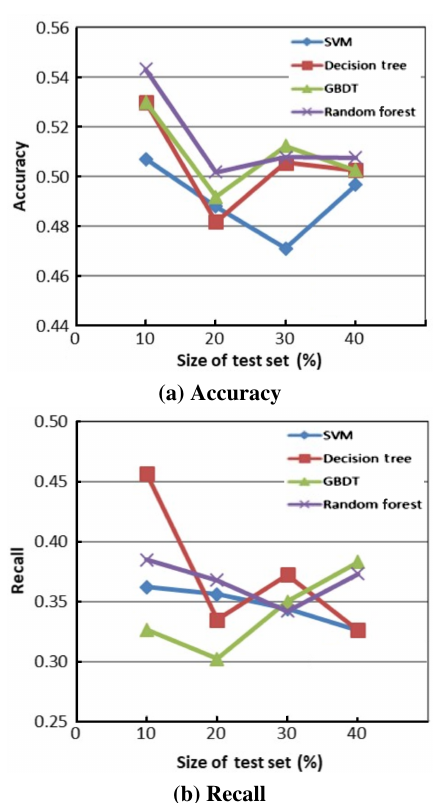
Fig. 4 Accuracy and recall of the five-layer model.